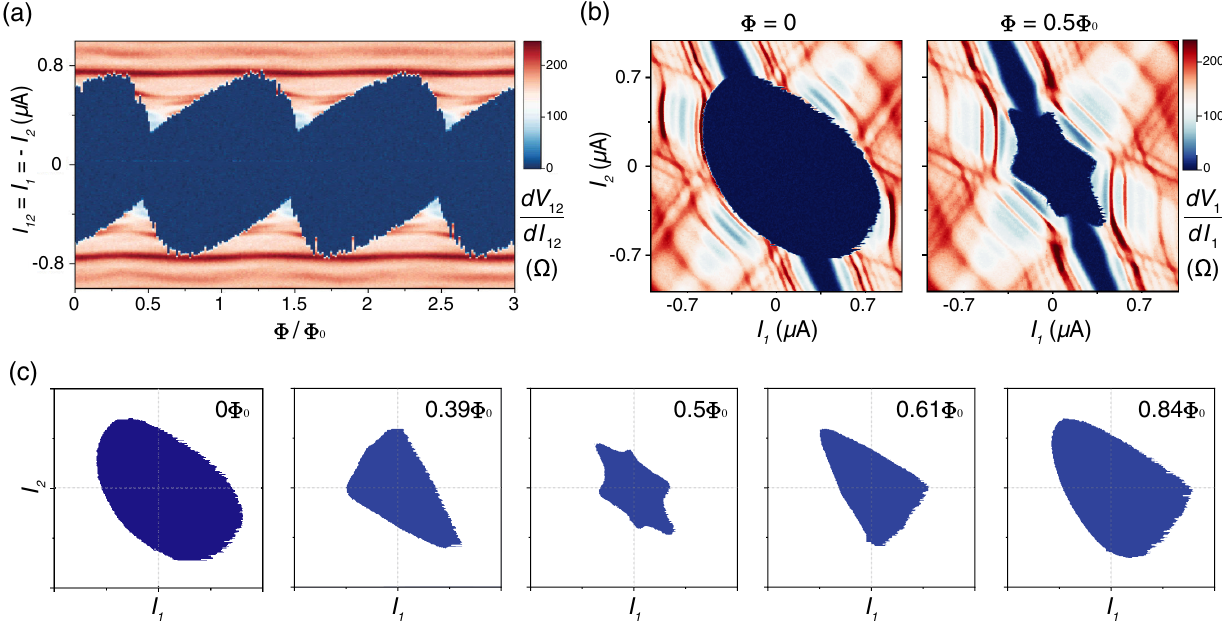
FIG. 6. Phase-drag effect and phase-controlled CCC in a multi-SQUID. (a) Differential resistance between terminal 1 and 2 as a function of the flux Φ through the loop in the device shown in Fig. 1(e); the loop is floating. Φ 0 ¼ h= ð 2 e Þ is the superconducting flux quantum. (b) Differential resistance of the terminal 1 as a function of the two currents I 1 , I 2 , for an integer flux (left) and a half-integer flux (right) though the loop; the loop is grounded. (c) Evolution of the CCC as a function of flux through the loop. Note the formation of an unusual inversion-symmetric star shape at the half-integer flux